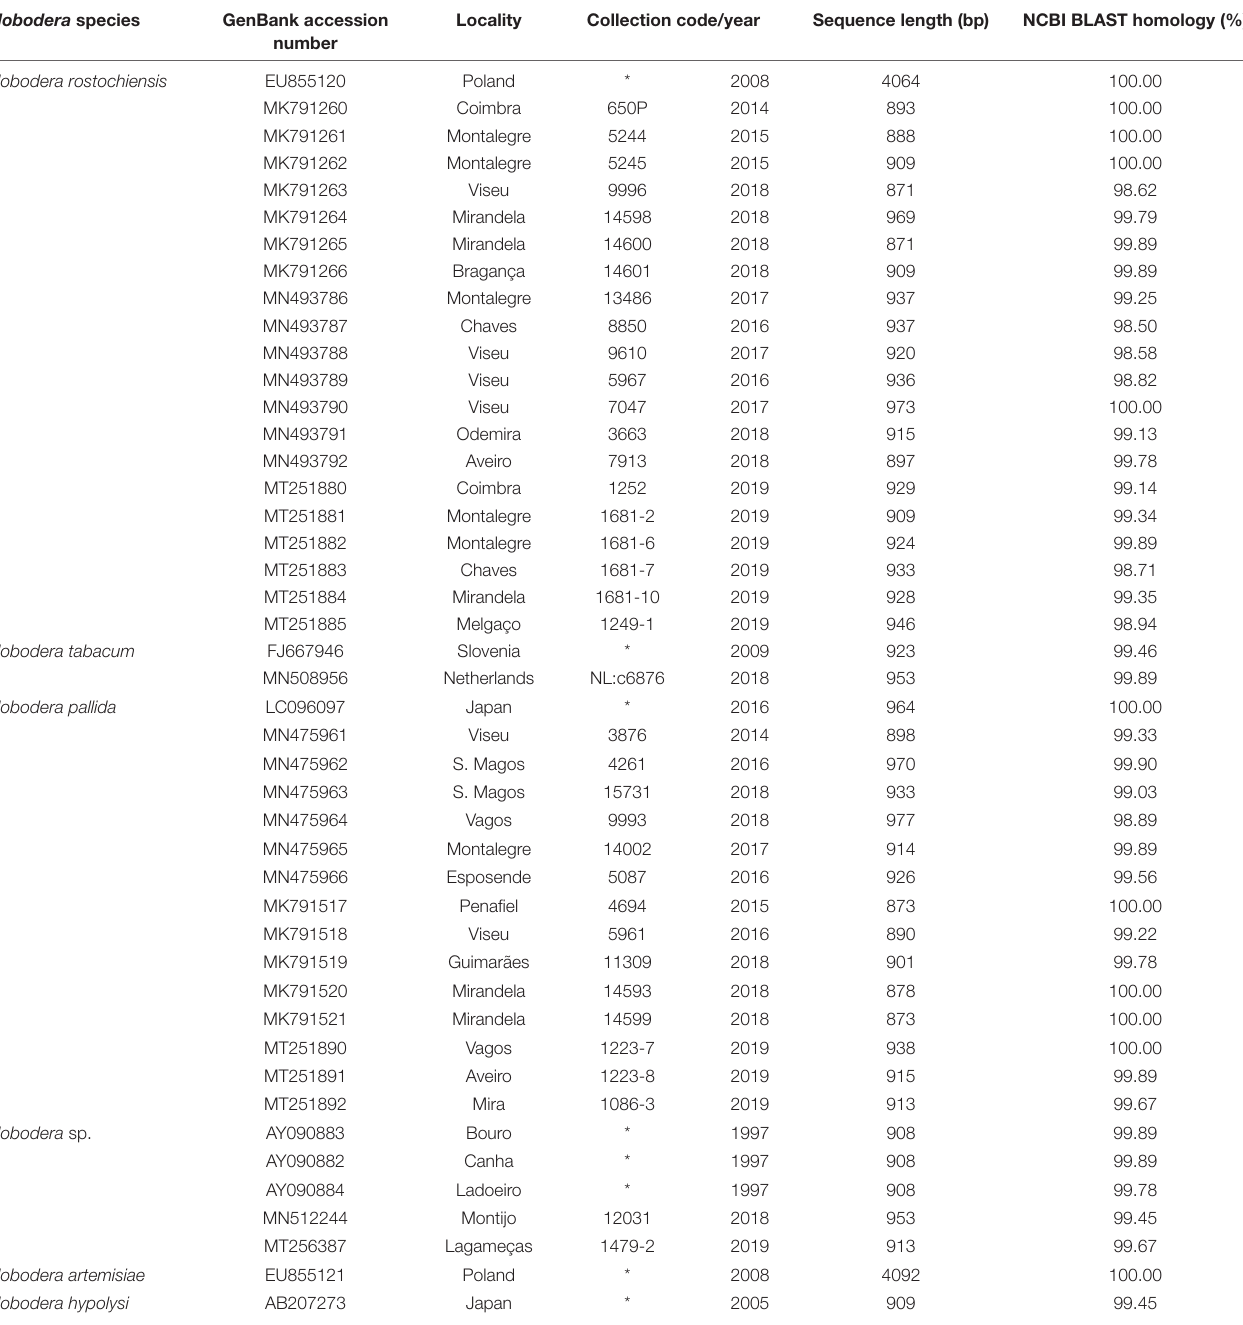
TABLE 3 | Globodera spp. isolates sequenced in the present study ( E -value = 0.0). Globodera